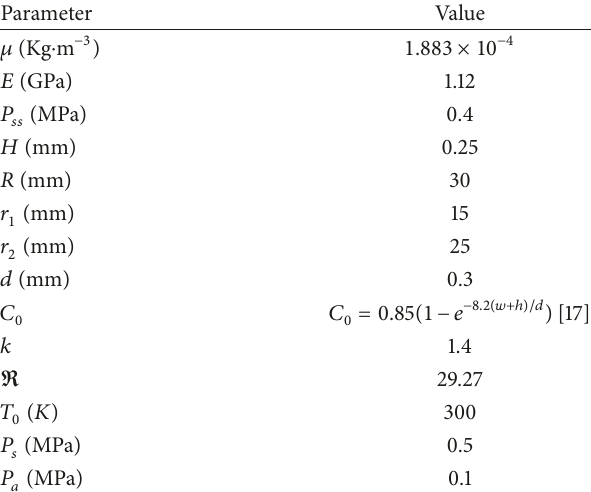
where 𝑖, 𝑗 are grid number in the direction of 𝑟, 𝜃 , respec- tively; Δ𝑟, Δ𝜃 are grid distance in the direction of 𝑟, 𝜃 , respectively.